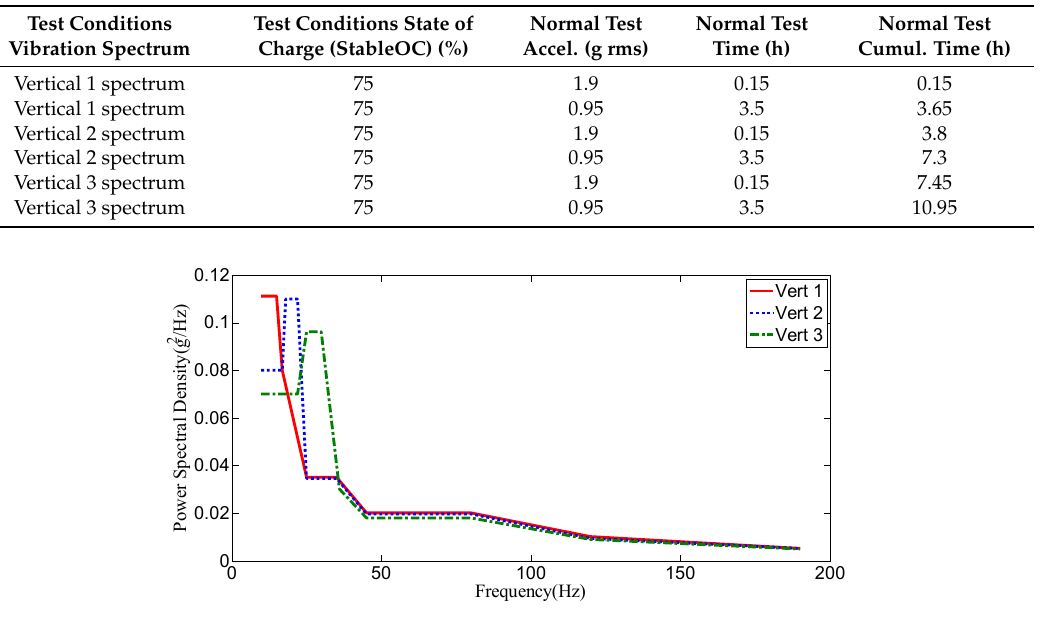
Figure 3. Vibration spectra for random vibration test referring to Society of Automotive Engineers (SAE) J2380 standard.